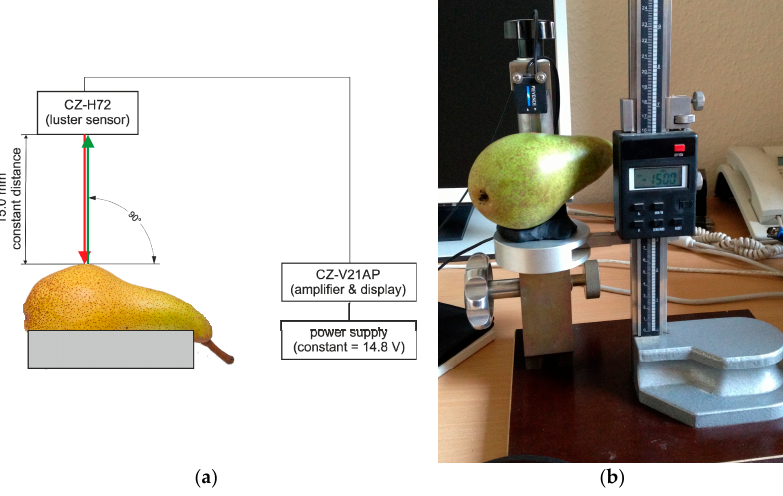
Figure 1. Measuring scheme (left, a ) for the detection of physical surface features with the luster sensor showing the micro-manipulator on the right ( b ).